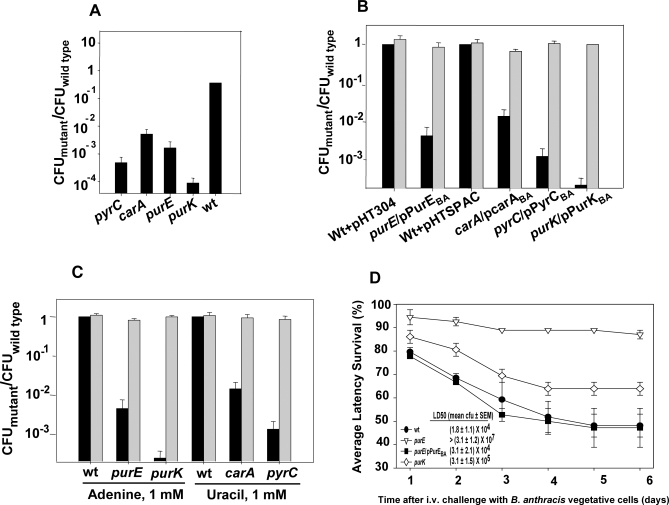

B. anthracis Nucleotide Biosynthetic Mutants Are Unable to Grow in Human Serum(A) Ratios of the viable cell counts of the carA, pyrC, purE and purK mutants as compared to wild-type B. anthracis after 24 h of growth in human serum (p value <1 × 10−5). Statistical significance of respective mutants relative to wild type was calculated using t-test in EXCEL.(B) Ratios of the viable cell counts of purE, carA, pyrC and purK mutants (black bars) and the viable cell counts of purE/pPurEBA, carA/pCarABA, pyrC/pPyrCBA, purK/pPurKBA, wt + pHT304 and wt + pHTSPAC (grey bars) to that of wild-type B. anthracis following 24 h of growth in serum.(C) Grey bars represent ratios of the viable cell counts of each mutant to that of wild-type B. anthracis after 24 h of growth in serum supplemented with 1 mM adenine (purine mutants) and 1 mM uracil (pyrimidine mutants). Black bars represent these ratios in serum without any nucleotide supplements. Error bars indicate SD of triplicate experiments.(D) Attenuation of B. anthracis purE mutant in a murine model of bacteremia. Survival curves (Average Latency Survival) were derived from transformation of daily LD50s estimated for mouse cohorts challenged intravenously with a dose range (103–108) of vegetative cells of the indicated B. anthracis strains. Points on survival curves represent the mean ± SEM values from three (Sterne, purE) or two (purE/pPurEBA, purK) different mouse experiments. LD50 values shown in the graph represent the final values estimated at the end of the 6-day observation periods. Survival results were unchanged when mice were observed for an additional 2 weeks.